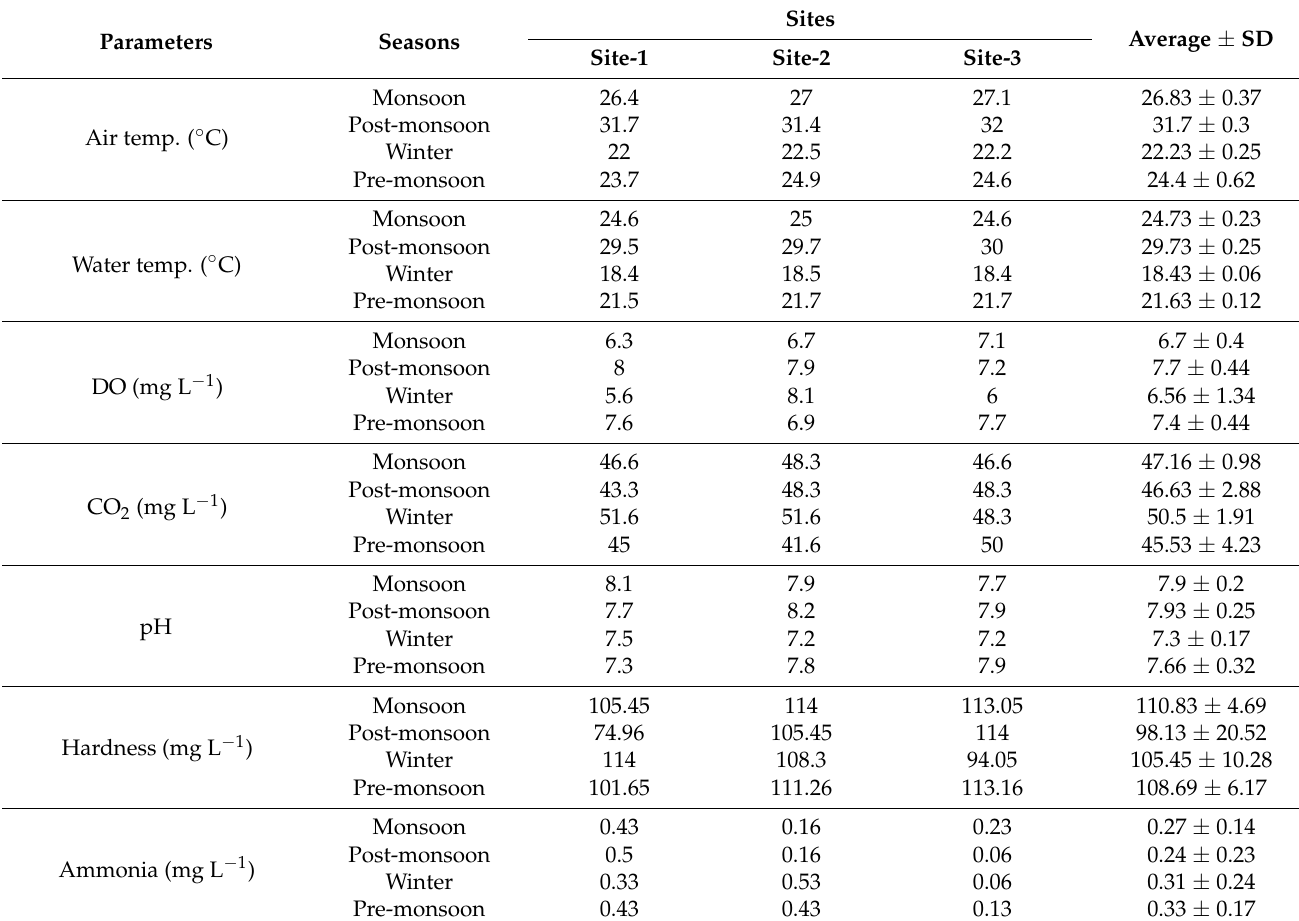
Table 4. Water quality parameters of the Hakaluki haor of Bangladesh (Average ±